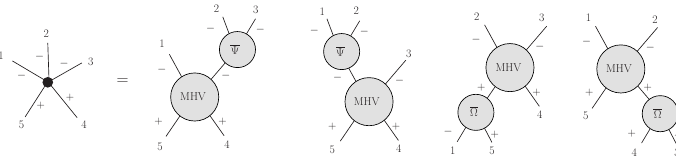
Figure 3: Contributions to the color-ordered ( −−− ++) MHV vertex. (Source of the figure: Ref. [ 8 ]